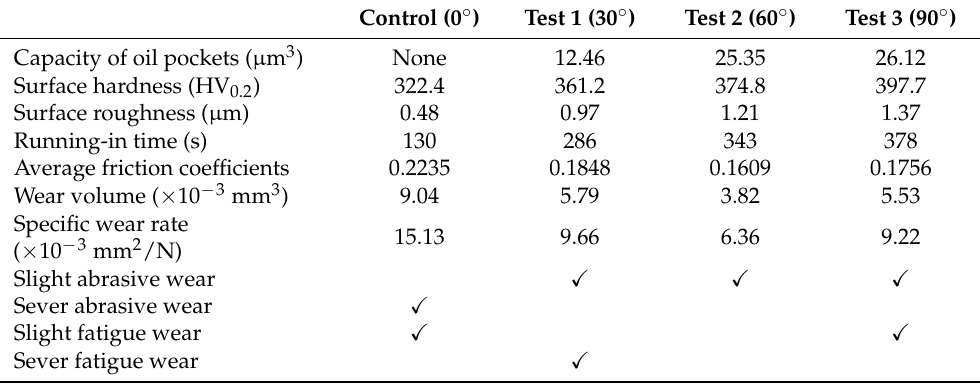
Table 4. Summary of surface microstructures and wear test results versus jet